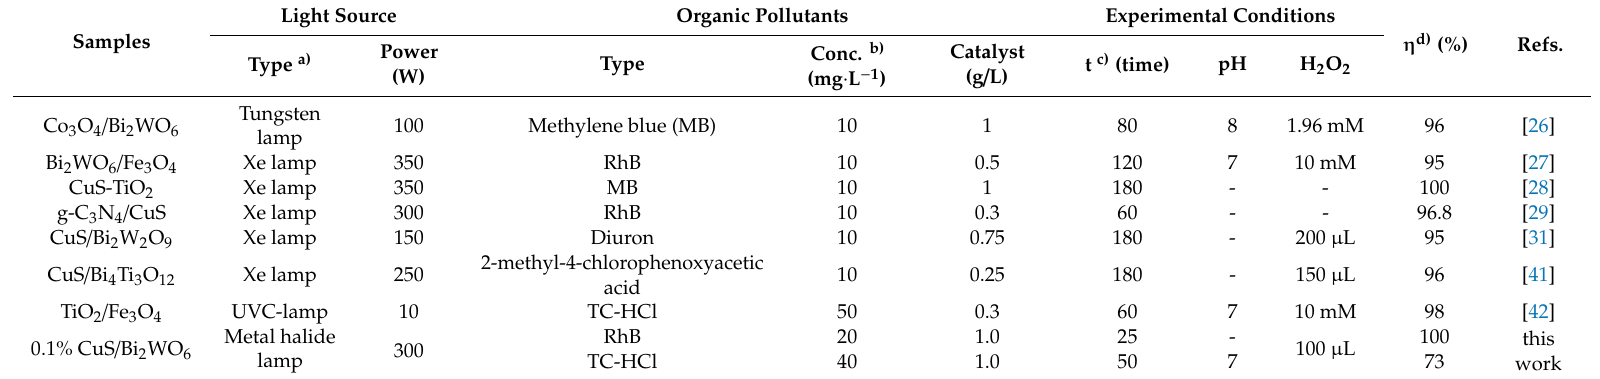
Table 1. Comparison of photo and photo-Fenton catalytic performance for removal of